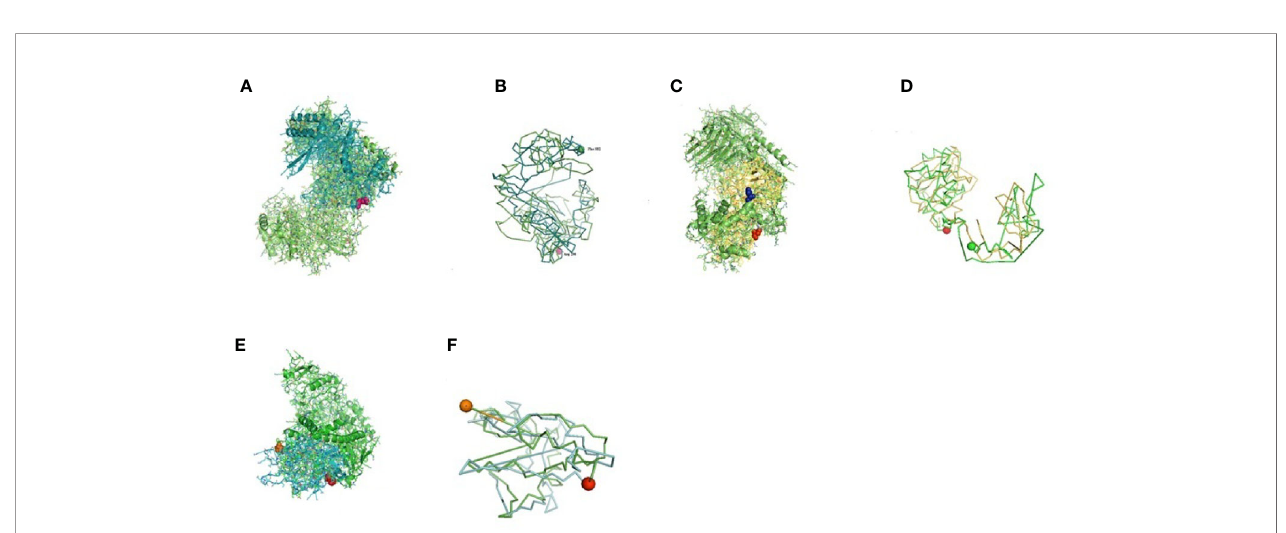
FIGURE 8 | (A) Molecular docking of parasitic protein Beta tubulin with ovine RIG-I, alignment (left) and binding site (right). (B) Molecular docking of parasitic protein Phosphoenol pyruvate carboxy kinase with ovine RIG-I, alignment (left) and binding site (right). (C) : Molecular docking of parasitic protein Cystein proteinase with ovine RIG-I, alignment (left) and binding site (right). (D, E) Molecular docking of parasitic protein Galaectin with ovine RIG-I, alignment (left) and binding site (right). (F) Molecular docking of parasitic protein Lectin with ovine RIG-I, alignment (left) and binding site